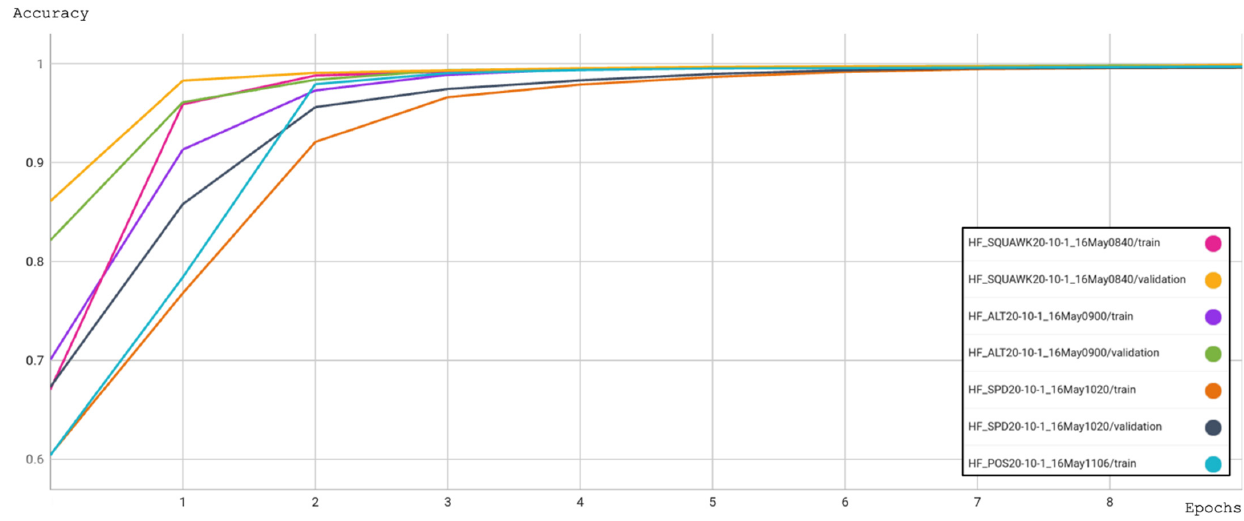
Figure 15. Human factors: model loss. Figure 14. Human factors: model accuracy.